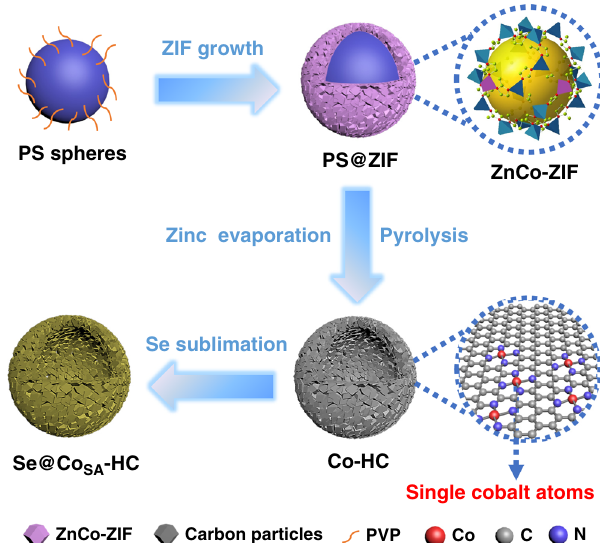
Fig. 1 SAC preparation process. Schematic illustration of the procedures for synthesising cobalt single atoms/nitrogen-doped hollow porous carbon (Co SA -HC)